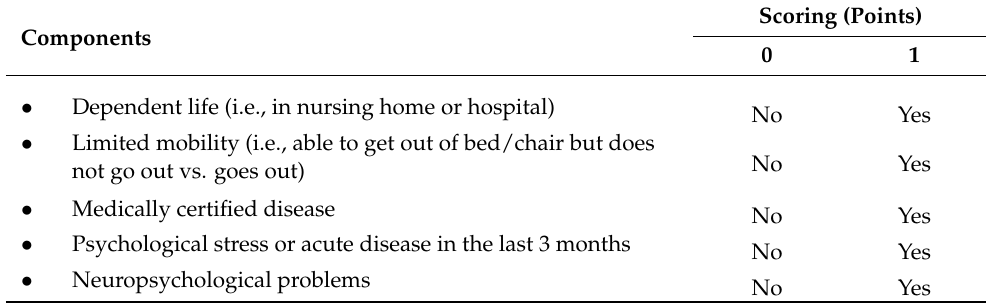
Table 2. Functional Limitations Score (FLS)—component data and scoring.